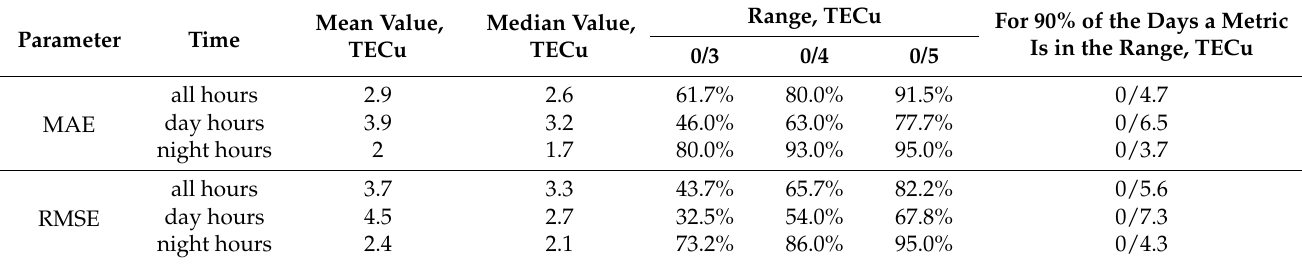
Table 6. Mean and median values and the percentage in a certain range for the MAE and RMSE scores for the PCA-MRM (L31, mean.lag1.2) model.